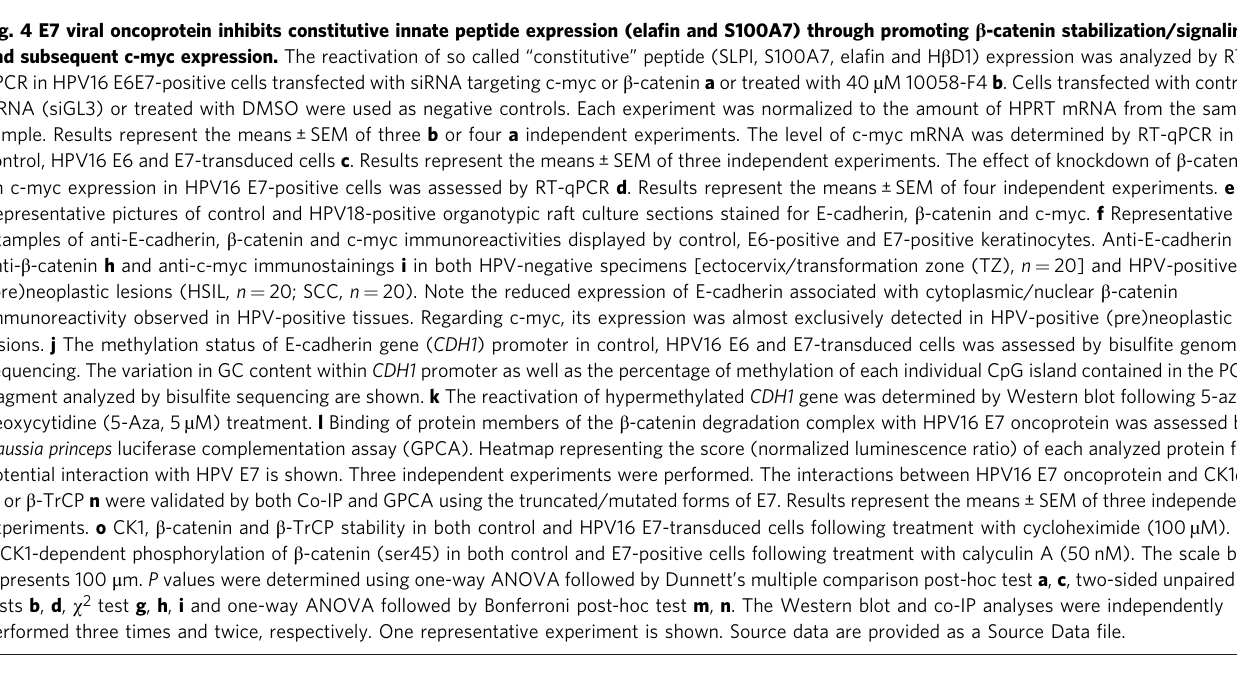
(Fig. 2b, c), all (excepted m β D4) antimicrobial peptides were signi fi cantly down-regulated in HPV16-expressing epithelia compared to their normal (uninfected) counterparts. Mouse β D12 was undetectable in all HPV-positive as well as in 7 out of